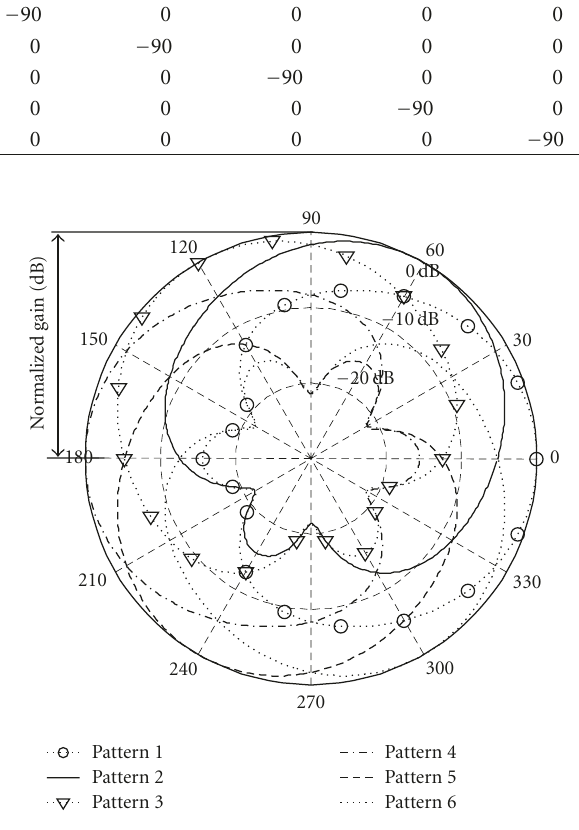
Figure 4: Six consecutive directional beam patterns generated by shifting the reactance